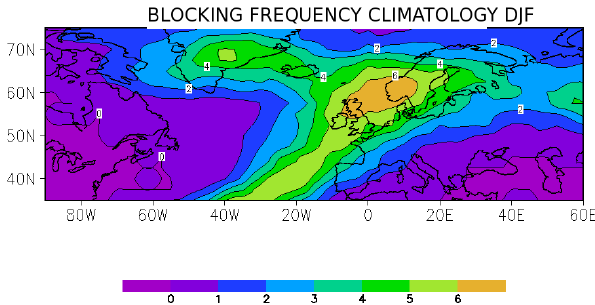
Fig. 3. Euro-Atlantic winter blocking frequency climatology of 5- day persistent blocking using the Scherrer et al. (2006) blocking indicator. Units are percentage of blocked days to total number of days per winter. Period is 1908–2005.